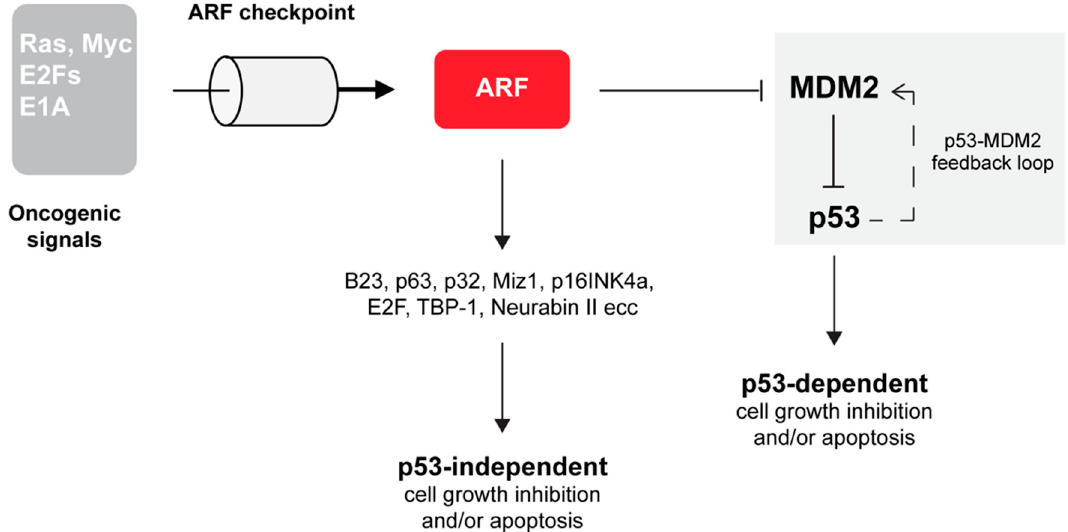
Figure 2. ARF involvement in tumor suppression relies on p53-dependent and independent pathways. Upon over-expression of oncogenes (such as E2F, Ras, E1A and Myc), an increase of ARF intracellular levels are promptly observed (ARF checkpoint) in the cell. By inhibiting MDM2 functions, ARF interferes with the p53/MDM2 circuit (highlighted in grey), leading to p53 stabilization followed by cell cycle arrest and/or apoptosis [10,32–35,39]. ARF is able to block cell growth also in a p53-independent manner, through the functional interaction with several molecular players as indicated.